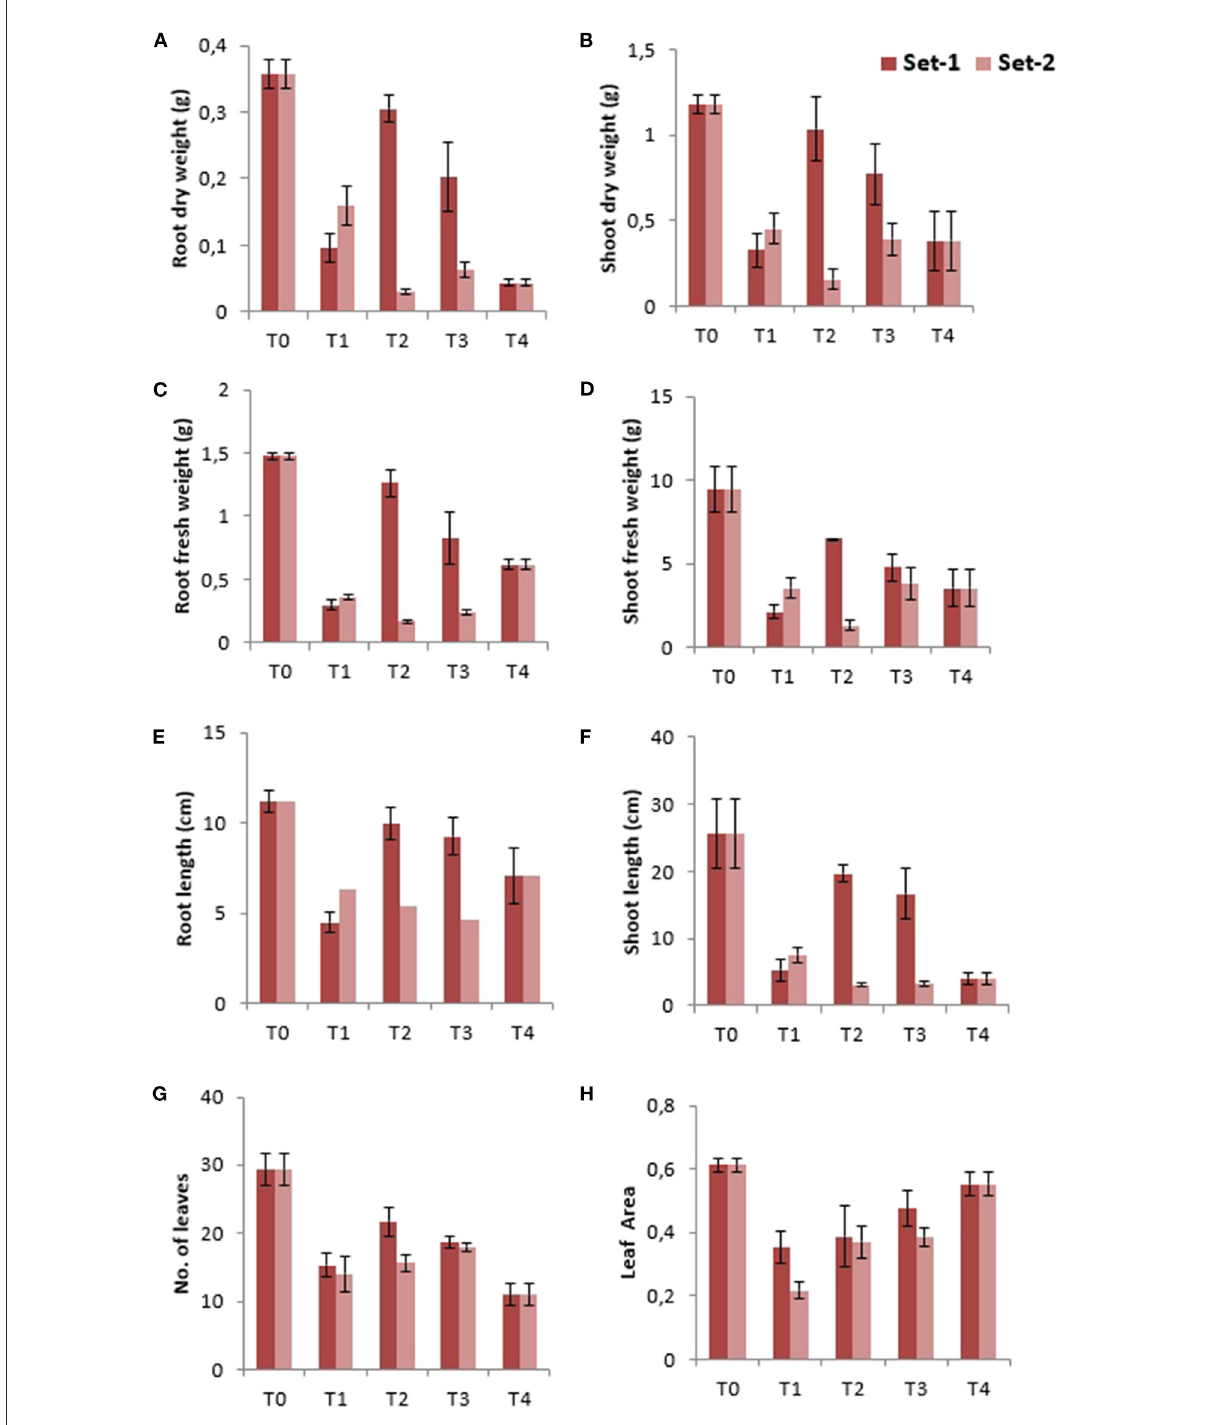
FIGURE5 Morphological attributes of P. hysterophorus in two sets of treatments. (A) root dry weight, (B) shoot dry weight, (C) root fresh weight, (D) shoot fresh weight, (E) root length, (F) shoot length, (G) number of leaves, and (H) leaf